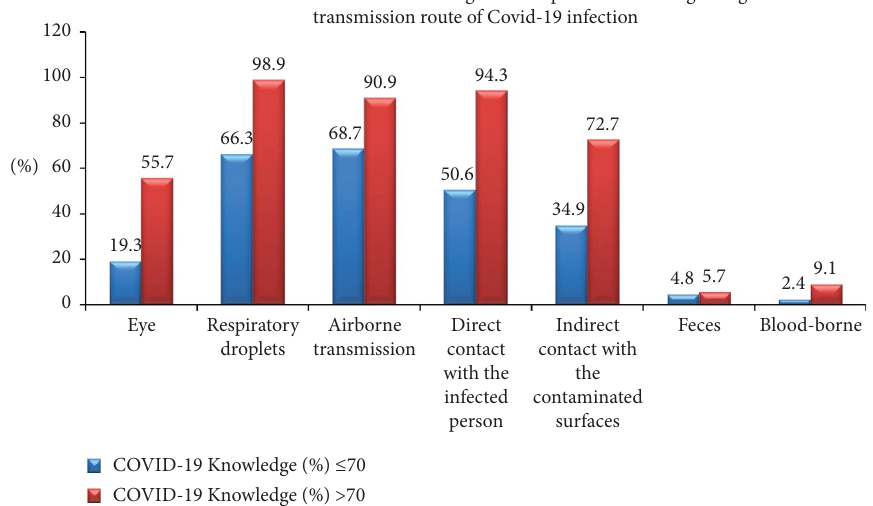
Figure 4: Association of COVID-19-related knowledge of the residents with their responses on the transmission route of COVID-19 infection.